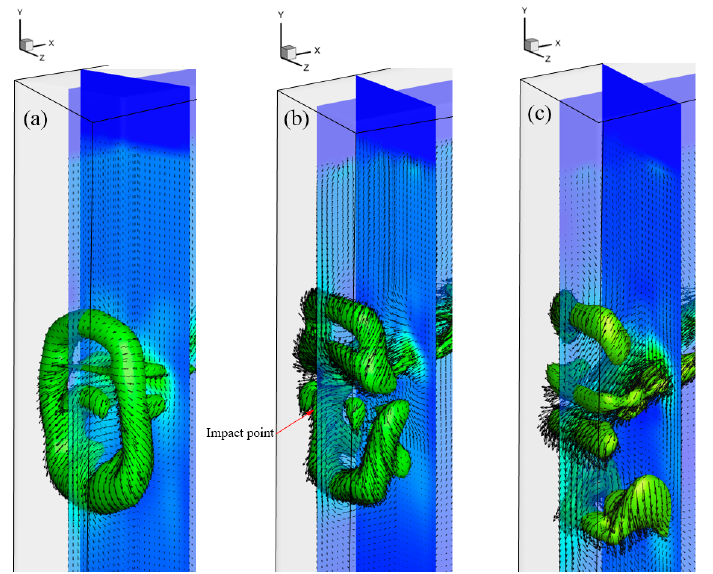
Figure 6. The transient process of the impact of the vortex structure in the jet flow at the narrow wall of the mold at different stages: ( a ) before the impact; ( b ) during the impact; ( c ) after the impact.